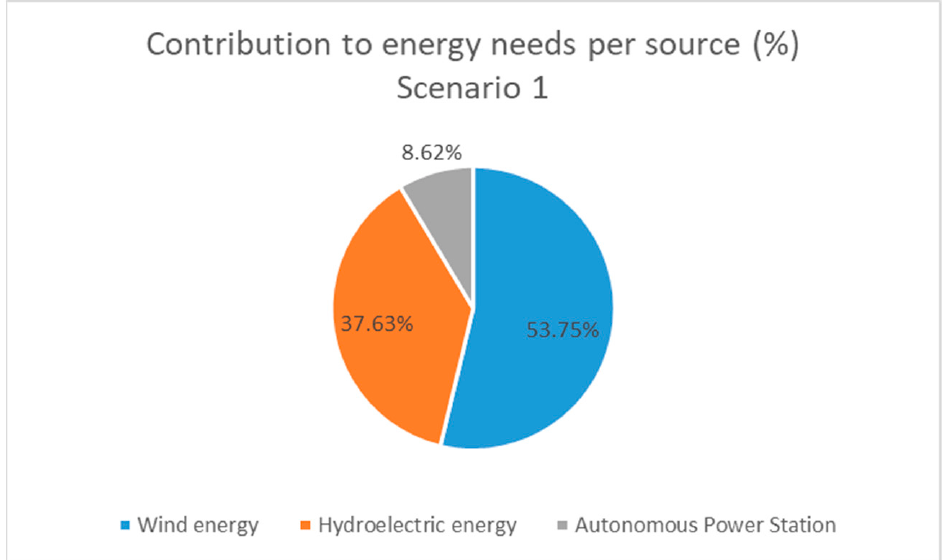
Figure 11. Contribution to energy needs per source, scenario 1.